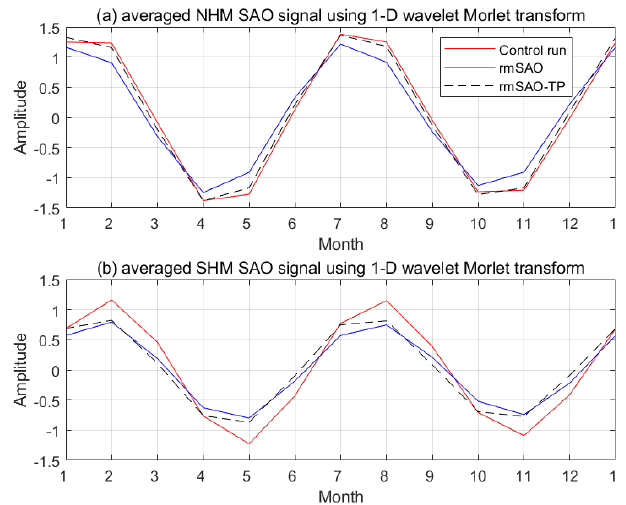
Figure 8. The average extracted SAO signals (5–7 months) based on 1-D wavelet Morlet transform for the Northern Hemisphere mid- latitudes (NHM) (a) and for the Southern Hemisphere mid-latitudes (SHM) (b) . The red, blue and dashed black lines are results of the control, rmSAO and rmSAO-TP runs, respectively.